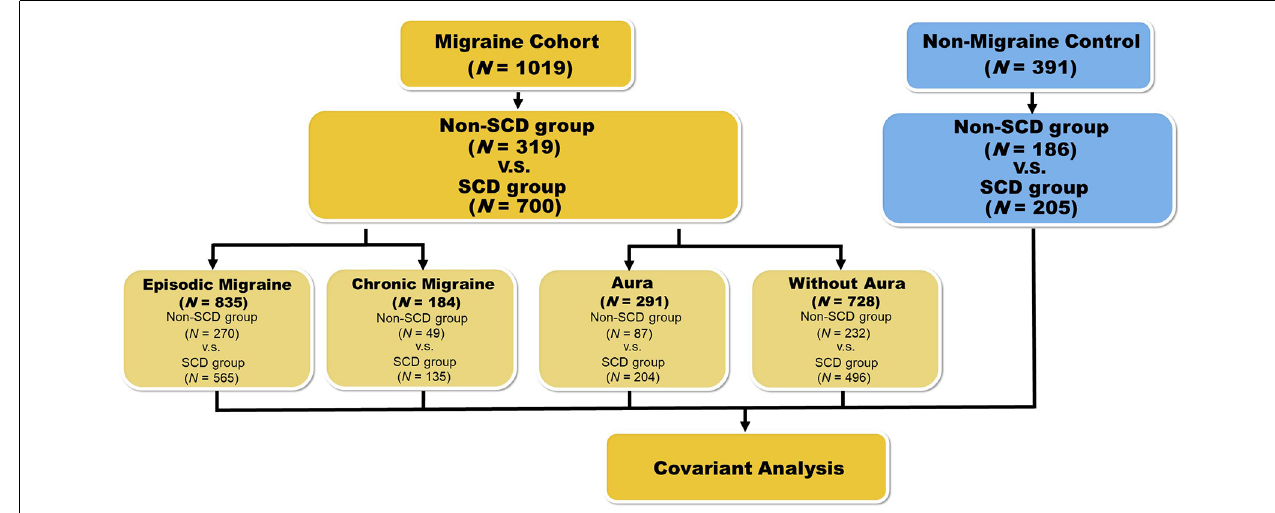
FIGURE 1 | Flowchart representing the workflow for the phenotype association study with variants. For the first phenotype association study, we divided the migraine patients into two groups: non-SCD and SCD. Results are presented in Table 2 . In the second round, samples were grouped based on four kinds of conditions: episodic migraine (EM), chronic migraine (CM), aura, and non-aura. The results of these subgroups are represented in Table 3 . We also performed a similar analysis on the healthy controls who were also grouped by SCD status. Results are represented in Table 4